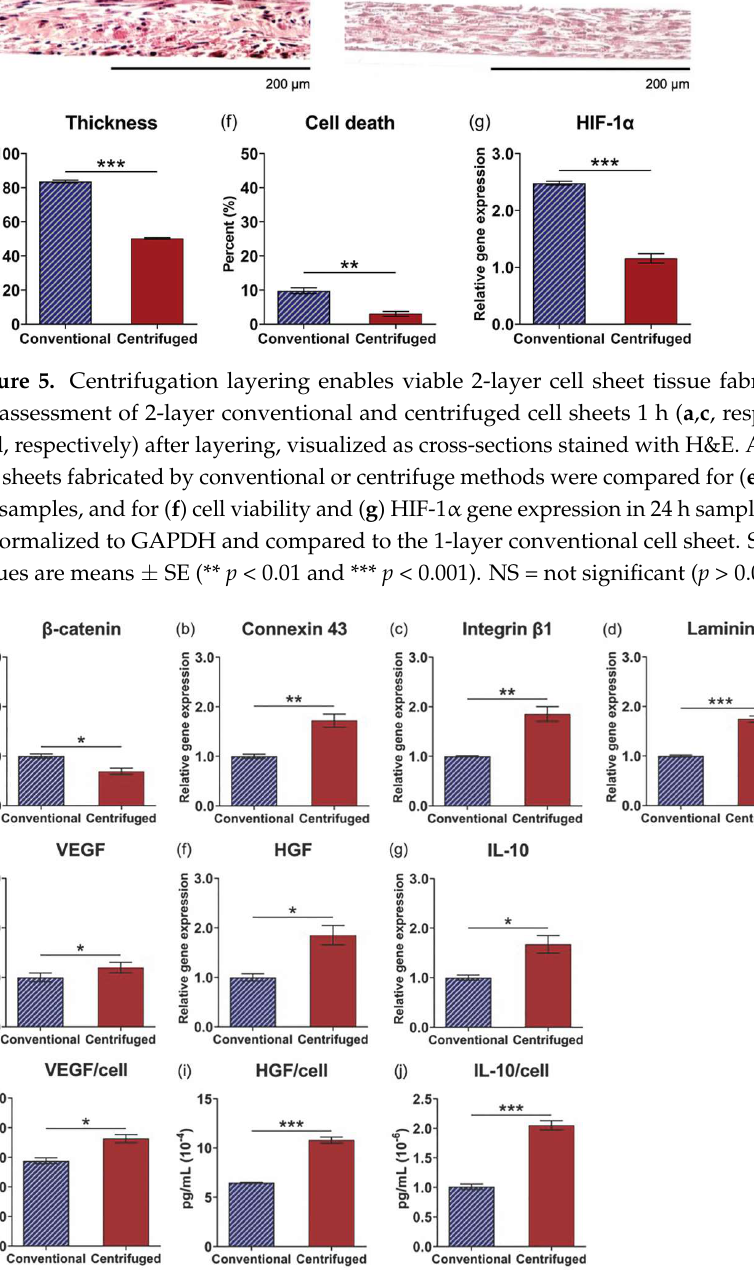
Figure 5. Centrifugation layering enables viable 2-layer cell sheet tissue fabrication. Histological assessment of 2-layer conventional and centrifuged cell sheets 1 h ( a , c, respectively) and 24 h ( b , d , respectively) after layering, visualized as cross-sections stained with H&E. Additionally, 2-layer cell sheets fabricated by conventional or centrifuge methods were compared for ( e ) tissue thickness in 1-h samples, and for ( f ) cell viability and ( g ) HIF-1α gene expression in 24 h samples. Gene expres- sion is normalized to GAPDH and compared to the 1-layer conventional cell sheet. Scale bars = 200 μm. Values are means ± SE (** p < 0.01 and *** p < 0.001). NS = not significant ( p > 0.05).